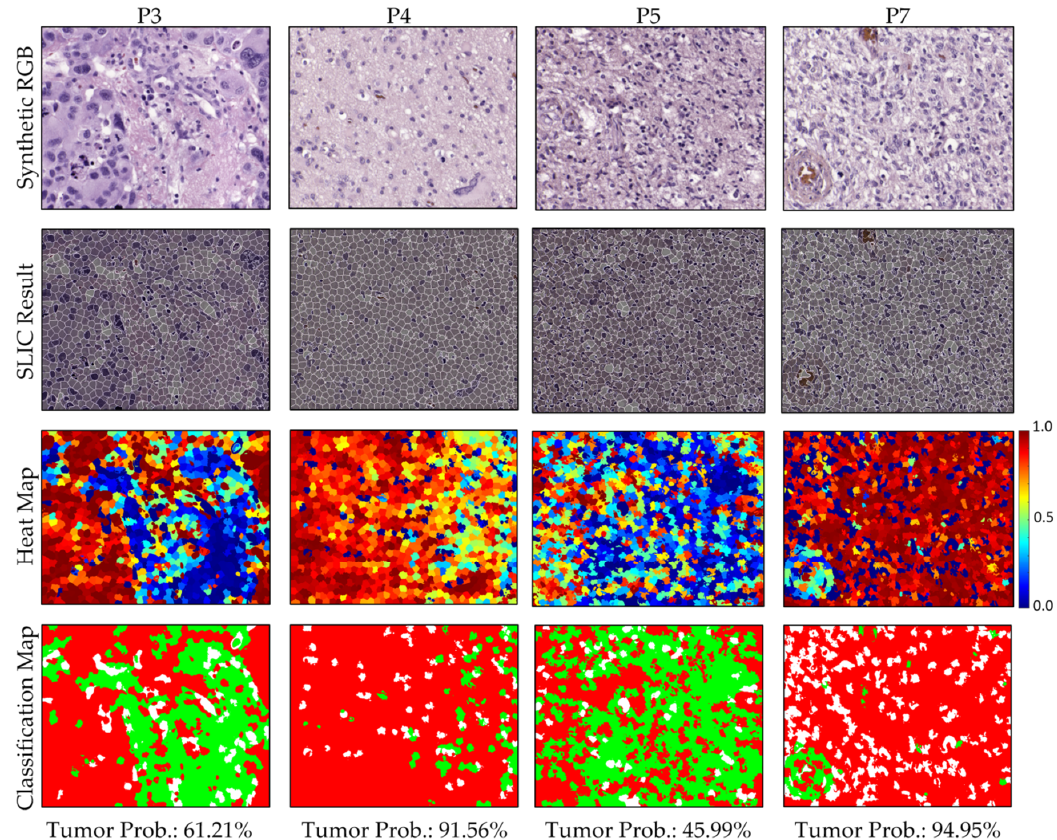
Figure 14. Heat and classification maps of four example tumor images. First row shows the synthetic RGB image of the HS cube, while second row represents the SLIC result. Third row represents the heat map, where red colors represent higher tumor probability. Fourth row shows the classification map, where red, green and white colors indicate tumor, non-tumor and light superpixels, respectively. In the last row, the tumor presence probability of the image is indicated. HS images with classification results with tumor probability >= 50% were considered tumor images, while results < 50% were considered non-tumor images.